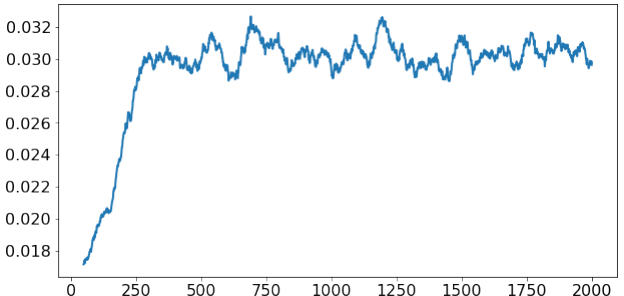
Figure 3. The expected payoff as a function of the number of epochs, evaluated for the parameters α = 0.5, µ = 0.2, σ = 1, r = 0.1, a = 1, b = 2 and h = 0.